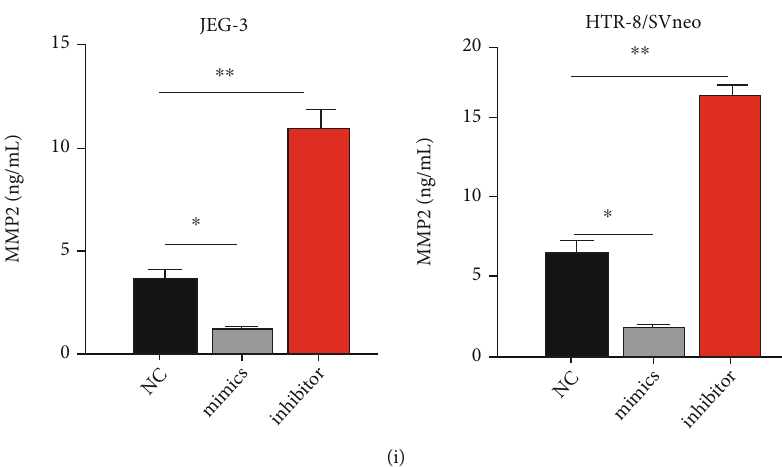
Figure 2: miR-155 regulated cell viability, apoptosis, mobility, and oxidative stress in trophoblast cells. Negative control (NC), miR-155 mimic, and the miR-155 inhibitor were transfected into HTR8/SVneo and JEG-3 cells. (a) RT-qPCR assay was used to measure the expression of miR-155 in the cells. (b, c) Cell Counting Kit-8 (CCK-8) assay was used to measure the cell viability after transfection in HTR8/SVneo and JEG-3 cells. (d) Detection of cell apoptosis by TUNEL assay. The nuclei of apoptotic cells had green fl uorescence. Hoechst staining showed that the nuclei of placental trophoblast cells were blue-violet. Microscopic images and quantitative analysis of Transwell migration (e) and invasion (f) in cells following transfection. (g) Western blot analysis was performed to determine the expression levels of proteins associated with apoptosis (CytC), invasion (MMP2), and oxidative stress (SOD1). (h) RT-qPCR assay and (i) ELISA were used to measure the expression of MMP2 in the cells. ∗ P < 0 : 05 , ∗∗ P < 0 : 01 , and ∗∗∗ P < 0 : 001